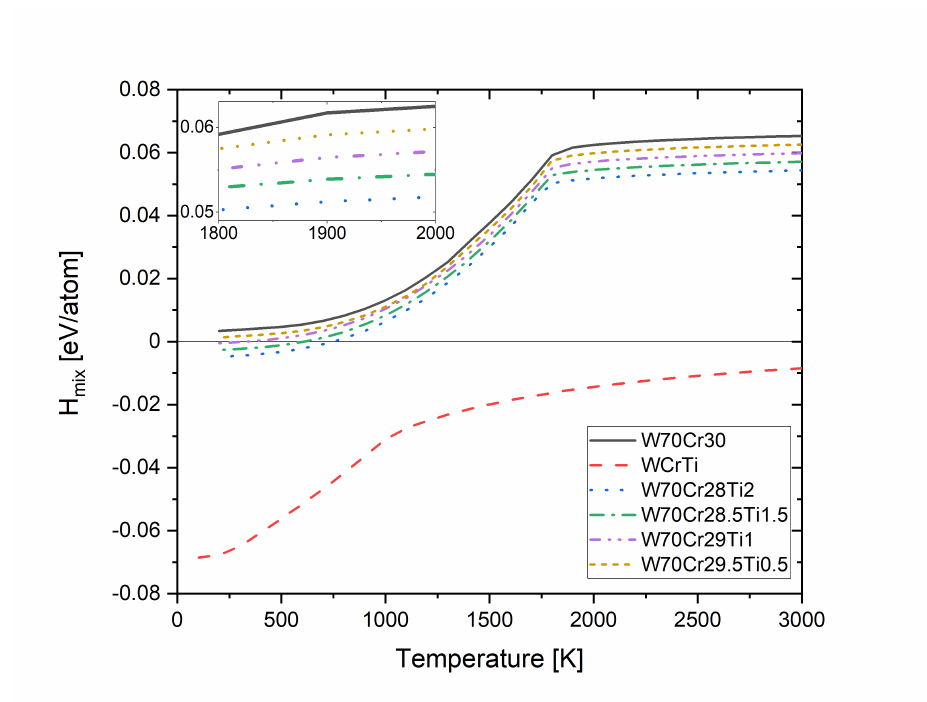
Figure 11. Enthalpy of mixing as a function of temperature for W 70 Cr 30 , equiatomic WCrTi, and derivative W 70 Cr ( 30 − x ) Ti x , for x = ( 0.5;1;1.5;2 ) alloys. The inset is a zoomed area of the pre- sented plot.